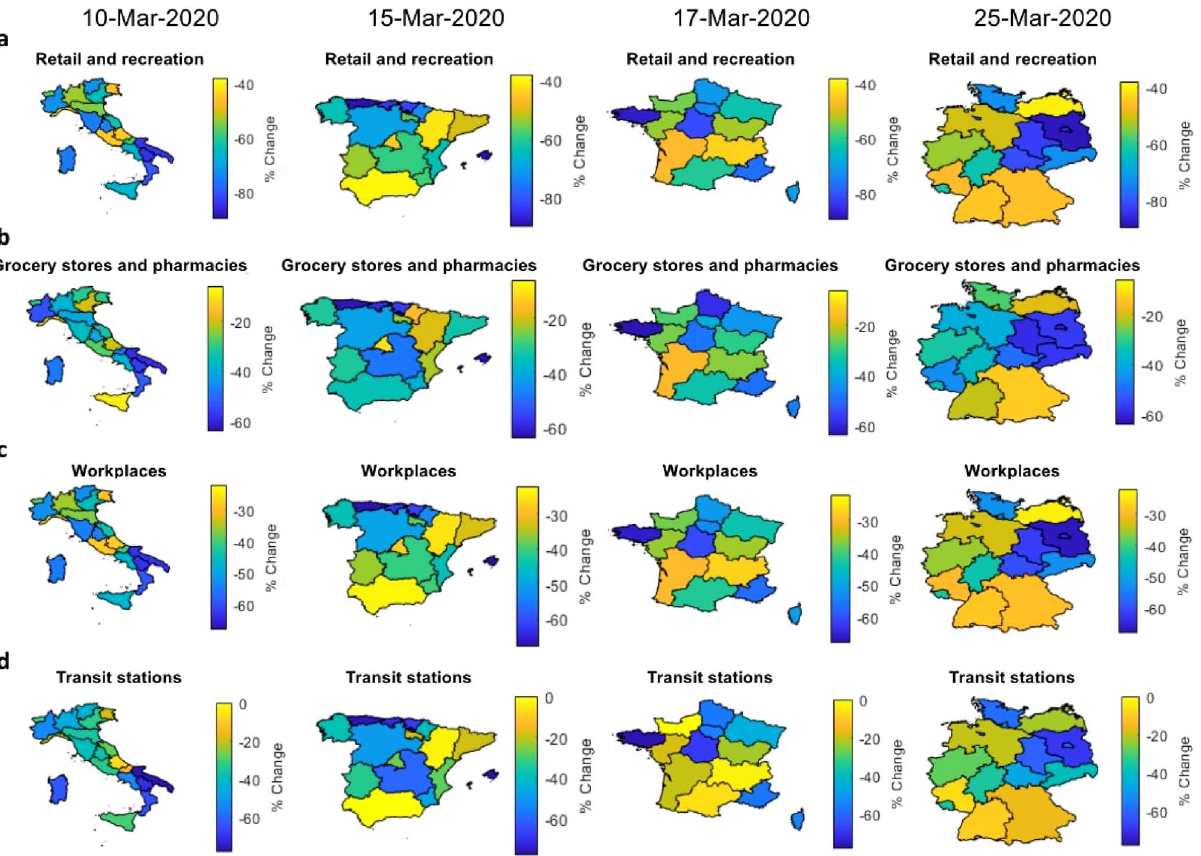
pharmacies ( b ), workplaces ( c ) and transit stations ( d ) across administrative regions in Italy, Spain, France and Germany at relevant dates within the first wave of the pandemic. Colors indicate the differences in percentage terms with respect to baseline. Administrative regions are at NUTS2 level (regional) for all the countries under analysis. Relevant dates represent the first day of lockdown for Italy (10 March 2020), Spain (15 March